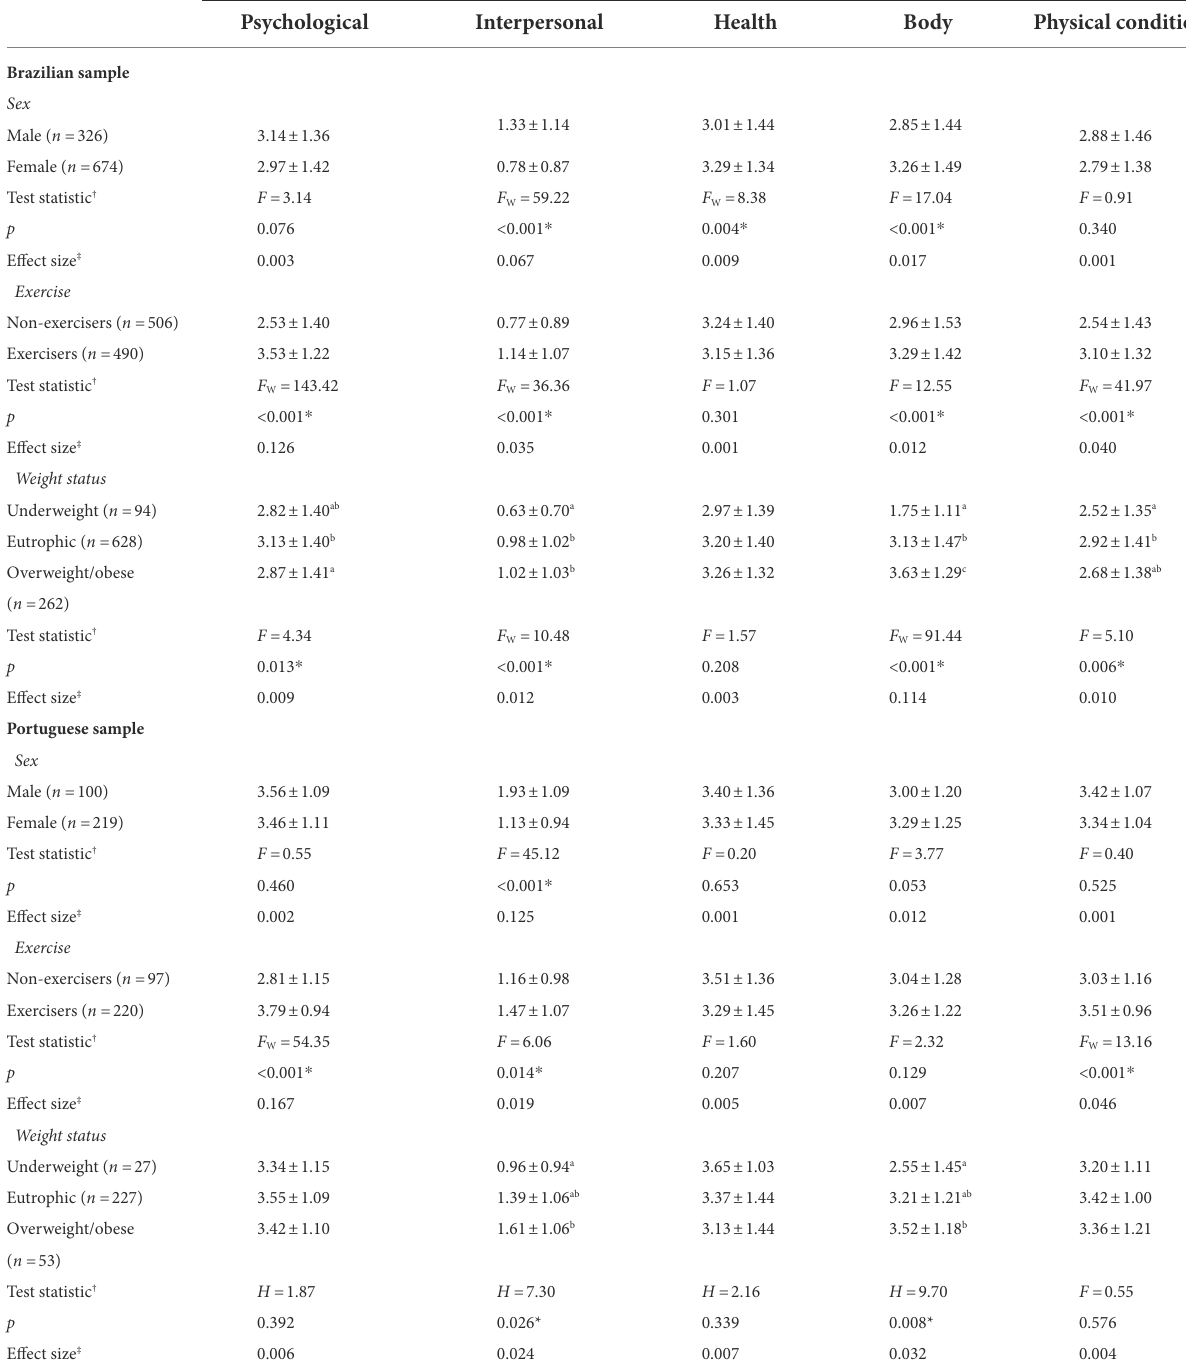
TABLE 5 Comparison of the mean scores (±standard deviation) of each domain (as proposed in this study) of the exercise motivations inventory-2 (EMI-2) according to sex, exercise, and weight status in the Brazilian and Portuguese samples. Proposed